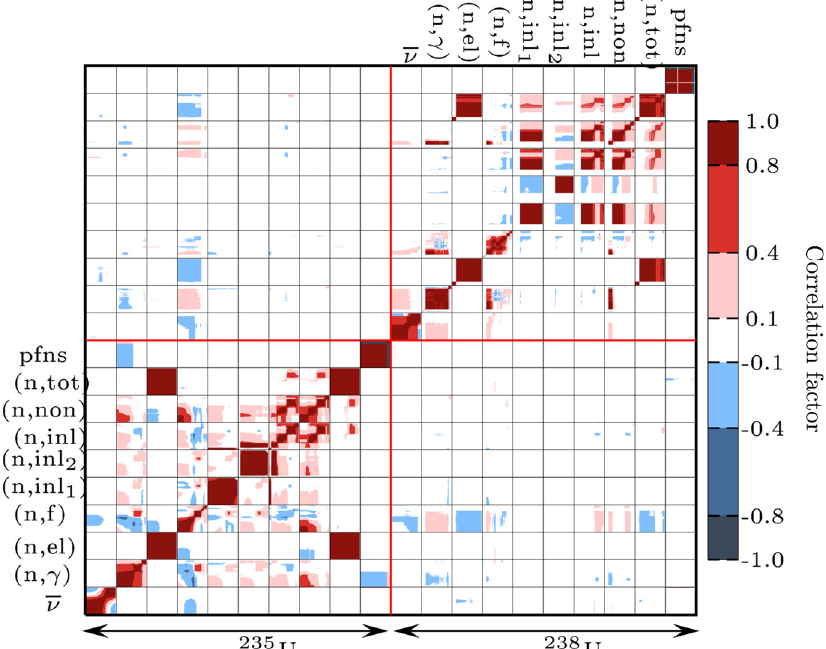
Fig. 3. Posterior (weighted) correlation matrices for a selection of cross-sections, nubar and pfns in the case of 235 U and 238 U, using IMF7 experimental k eff value as a constraints in the Bayesian TMC process. In each sub-block, the cross-sections are presented as a function of the incident neutron